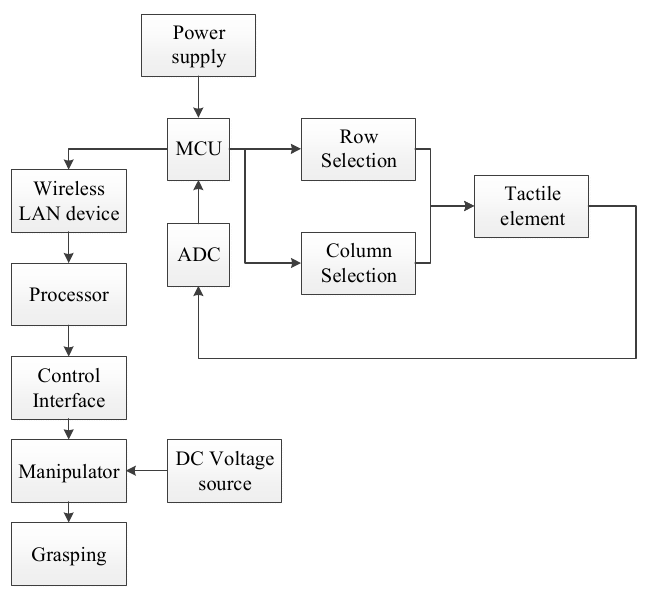
Figure 5. Block diagram of sensor array scanning circuit and grasping system.